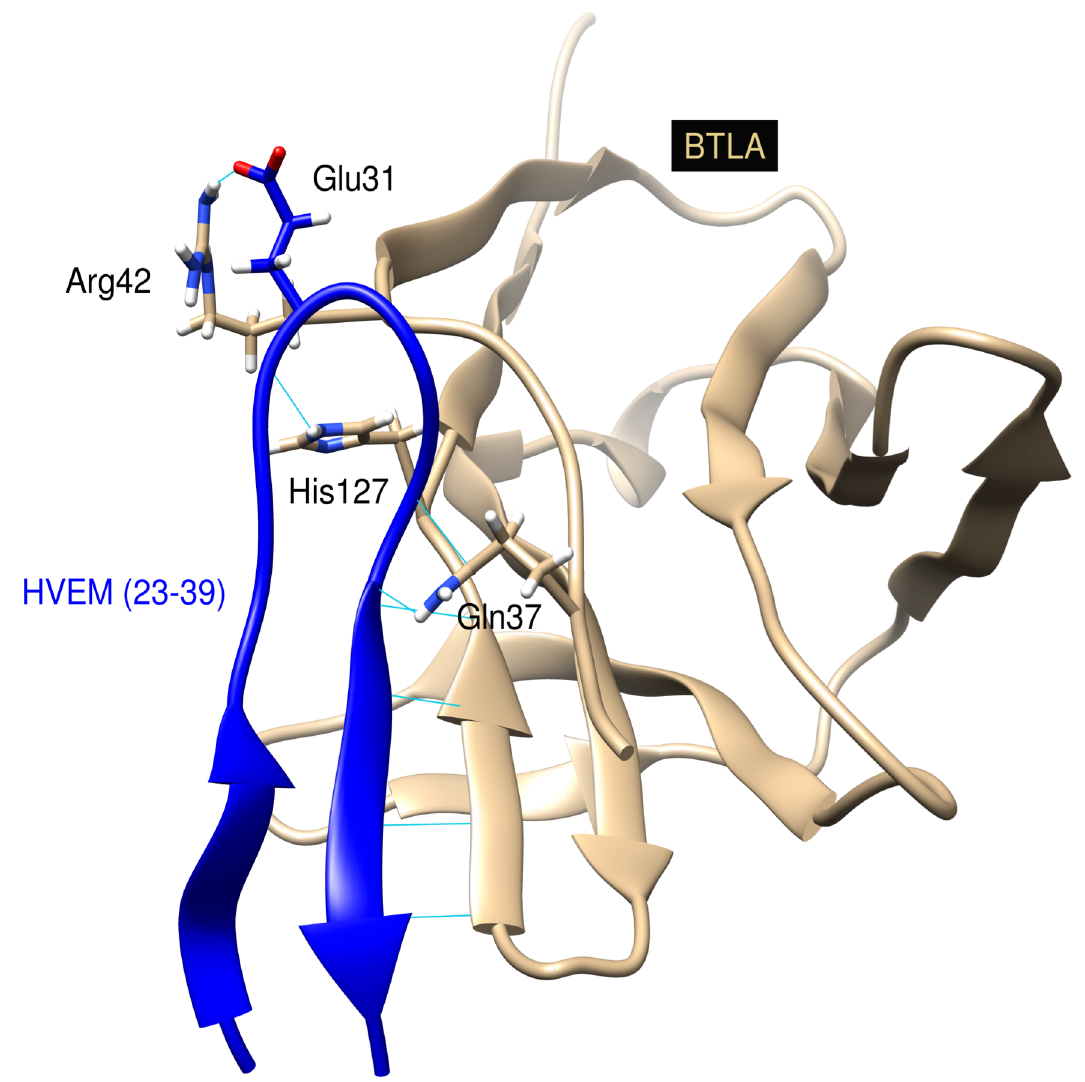
Fig 1. Structure of the BTLA/HVEM(23–39)peptide complex. HVEM(23–39) peptideis shown in dark blue ribbon, BTLA in beige and the side chains of residues involvedin the inter-molecular hydrogenbonds in stick representation with nitrogen atoms colored in blue, oxygen coloredin red and hydrogen atoms in white. Hydrogenbonds are representedby light blue lines.